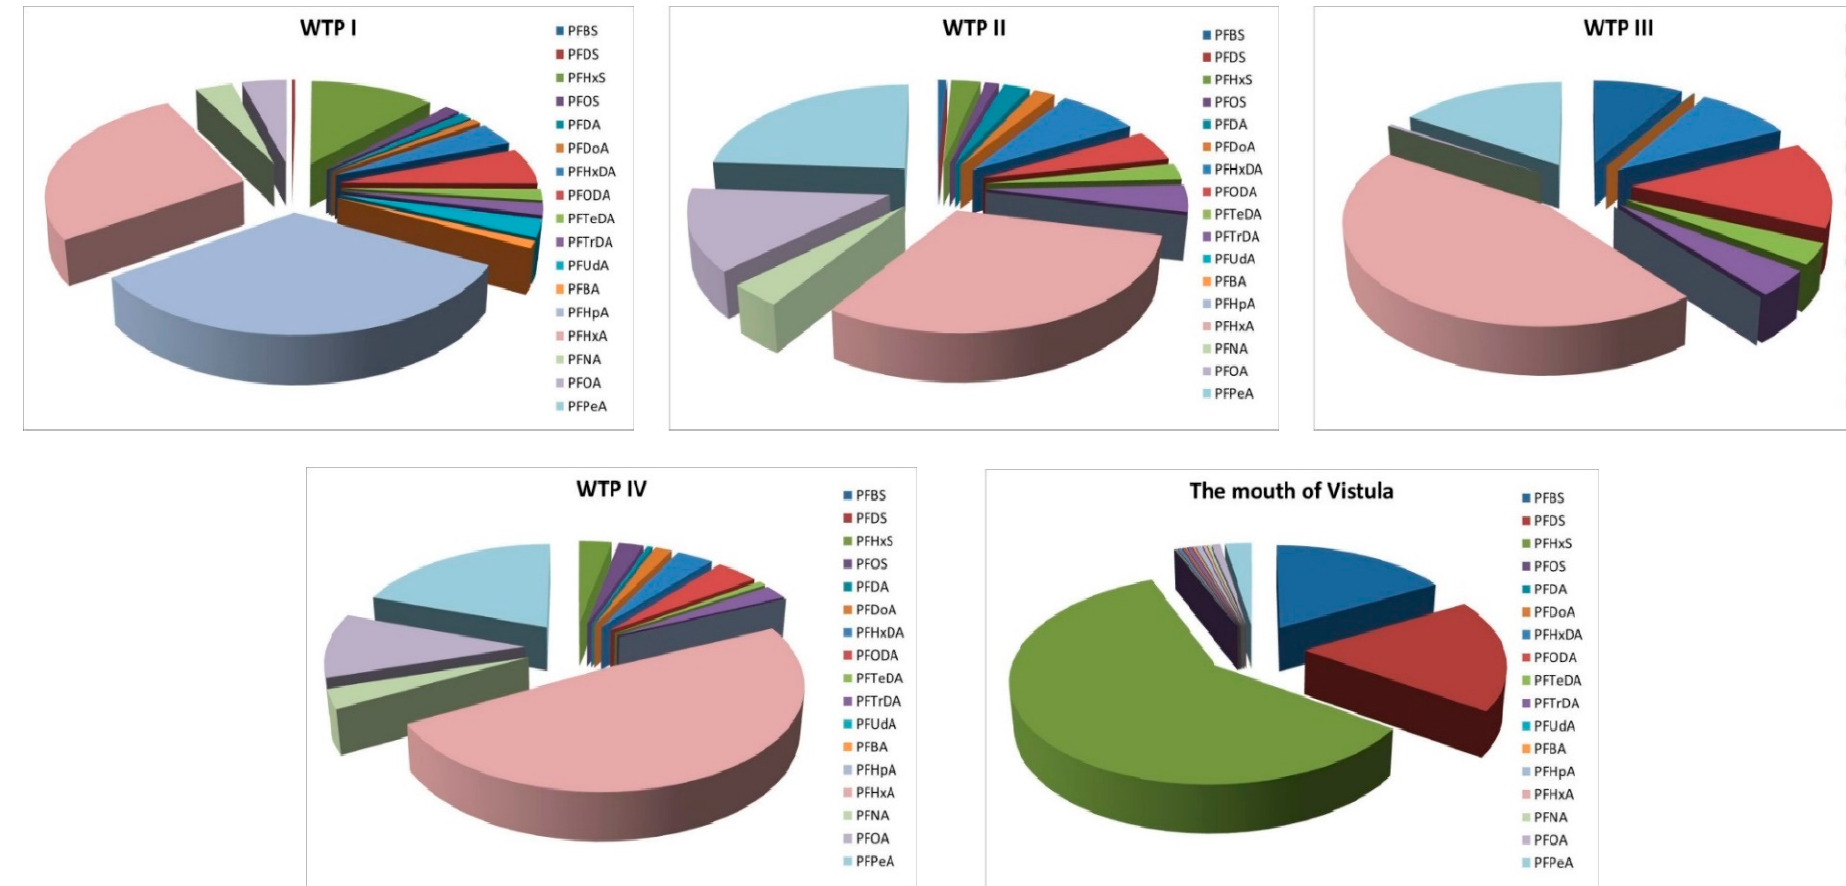
Figure 4. Percentage composition of the PFASs in samples taken around the sewage collectors’ outlets from wastewater treatment plants (WTP I-WTP IV) and from the mouth of Vistula (PFBA-perfluoro- n -butanoic acid, PFPeA-perfluoro- n -pentanoic acid, PFHxA-perfluoro- n -hexanoic acid, PFHpA-perfluoro- n -heptanoic acid, PFOA-perfluoro- n -octanoic acid, PFNA-perfluoro- n -nonanoic acid, PFDA-perfluoro- n -decanoic acid, PFUdA-perfluoro- n -undecanoic acid, PFDoA-perfluoro- n -dodecanoic acid, PFTrDA-perfluoro- n -tridecanoic acid, PFTeDA-perfluoro- n -tetra-decanoic acid, PFHxDA-perfluoro- n -hexadecanoic acid, PFODA-perfluoro- n -octadecanoic acid, PFBS-potassium perfluoro-1-butanesulfonate, PFHxS-sodium perfluoro-1-hexanesulfonate, PFOS-sodium perfluoro-1-octanesulfonate, PFDS-sodium perfluoro-1-decanesulfonate).